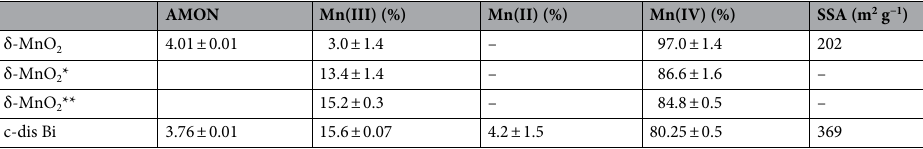
interactions between the protonated buffers and negatively charged mineral surface are more favourable, the reaction may be kinetically enhanced, allowing those treatments to reach steady state more quickly 60–62 . Given that Mn(II) oxidation by dissolved oxygen may be relevant at the timescale of the reaction for pH values > 8.5 63 , surface catalysed oxidation of Mn 2+ by oxygen may contribute to the decreased Mn reduction observed at the highest pH treatments (pK a + 1) for HEPES- and TRIS-reacted δ-MnO 2 . The reduction of δ-MnO 2 by HEPES, PIPES, MOPS, and MES generated mostly solid-phase Mn(III), with HEPES buffer reducing up to 35% of the initial Mn to solid-phase Mn(III) at pH 6.7 after 24 h and reduc- tion by the other buffers following closely behind (Fig. 1). For HEPES we found good agreement between the pyrophosphate-extractable Mn(III) and the AMON value, therefore we assume minimal sorbed Mn(II) (Sup- plementary Table S2). Measurable amounts of Mn aq were only observed in Good’s buffer treatments where pH < 7 (Supplementary Table S2). Most cases generated less than 4 µM aqueous Mn after one hour of reaction; however, after 24 h, we detected 20–50 μM aqueous Mn for reactions run at pH values equal to 1 unit below the pK a for all buffers except MOPS, which generated minimal aqueous Mn (< 1% or 4.1 µM; ~ 410 µM Mn tot ) under all conditions tested. For MES, PIPES, and HEPES we measured 23, 49 and 21 μM aqueous Mn, respectively (these reactions were run using about 503, 1030, 853 µM Mn tot ; see Supplementary Table S2). As aqueous Mn(III) is unstable unless in the presence of high-affinity complexing agents with multiple functional moieties (e.g., pyroph-